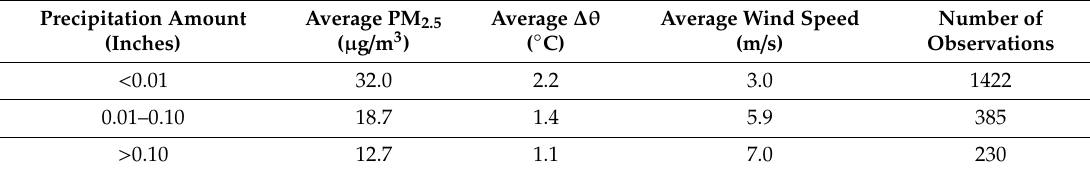
Table 7. Average PM 2.5 , ∆ θ and wind speed by precipitation category.